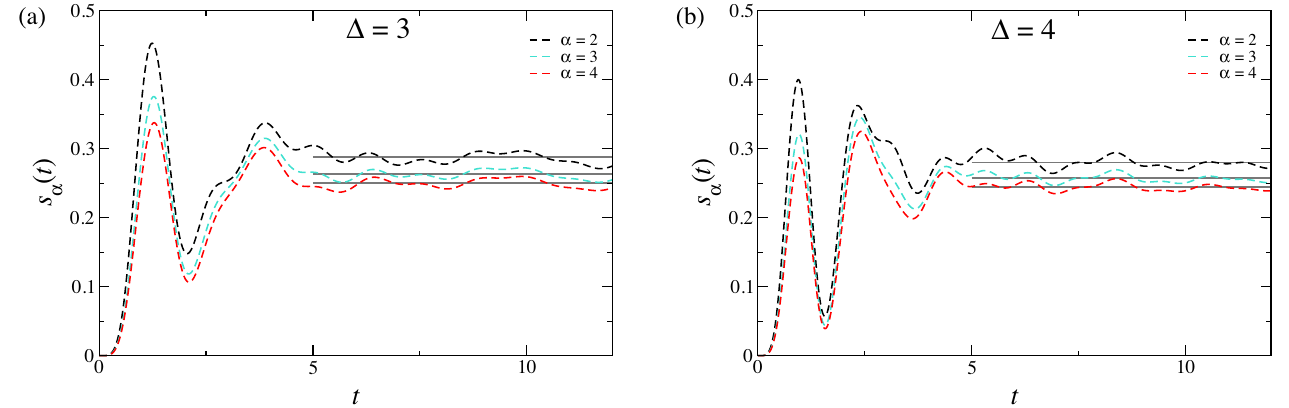
FIG. 5. Dynamics of the instantaneous R´enyi slope s α ð t Þ after the quench from the Majumdar-Ghosh state (81). The dashed lines represent the numerical data, and solid lines denote the analytical predictions for the asymptotic slope s α . Different colors distinguish between different α , while the value of the anisotropy parameter is Δ ¼ 3 in (a) and Δ ¼ 4 in